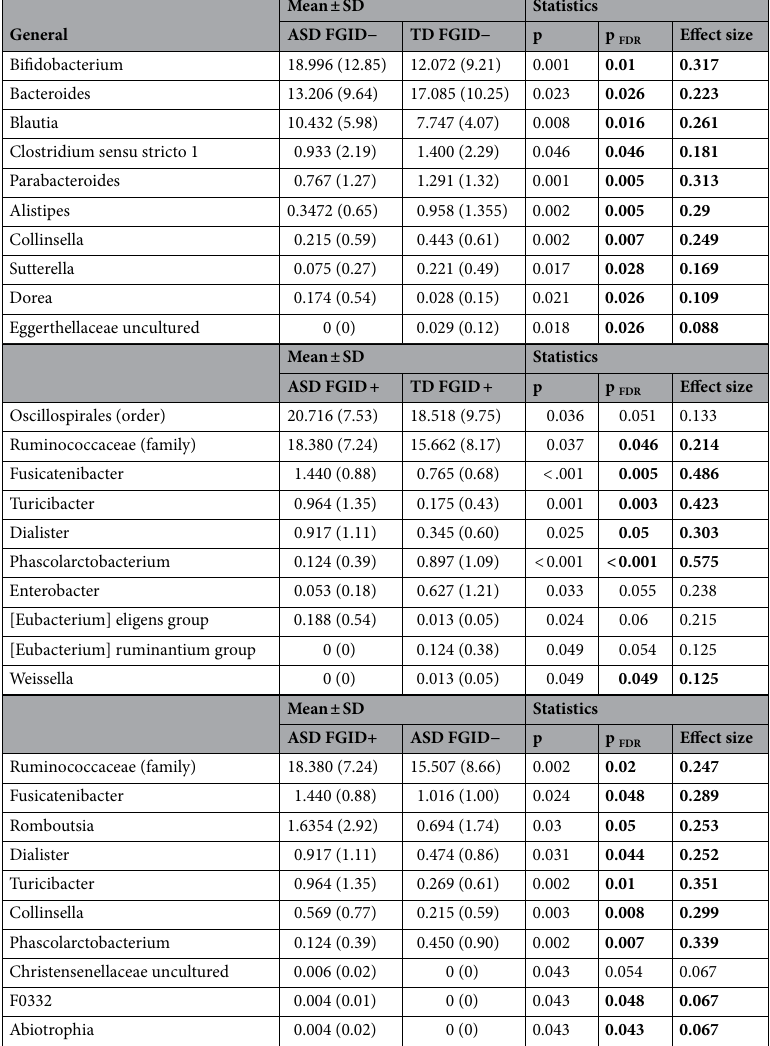
Table 5. Comparison of the relative abundance at genus level between ASD and TD groups. Significant values are in bold. ASD Autism Spectrum Disorder, TD Typically Developing, FGID Functional